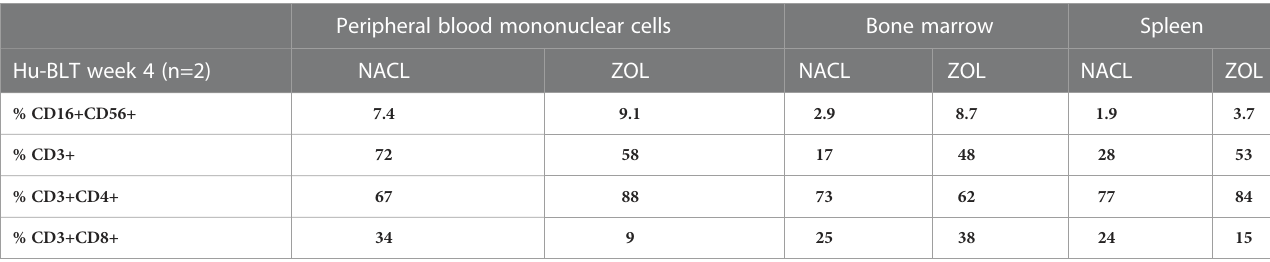
Hu-BLT mice were administered with either 0.9% NACL or ZOL (500 μg/kg) via IV as described in Materials and Methods section. Four weeks after injections, mice were euthanized and tissues were harvested to obtain single cell suspension. Immune cell composition was determined in PBMCs (n=2), bone marrow (n=2), and splenocytes (n=2) of hu-BLT mice using fl ow cytometric